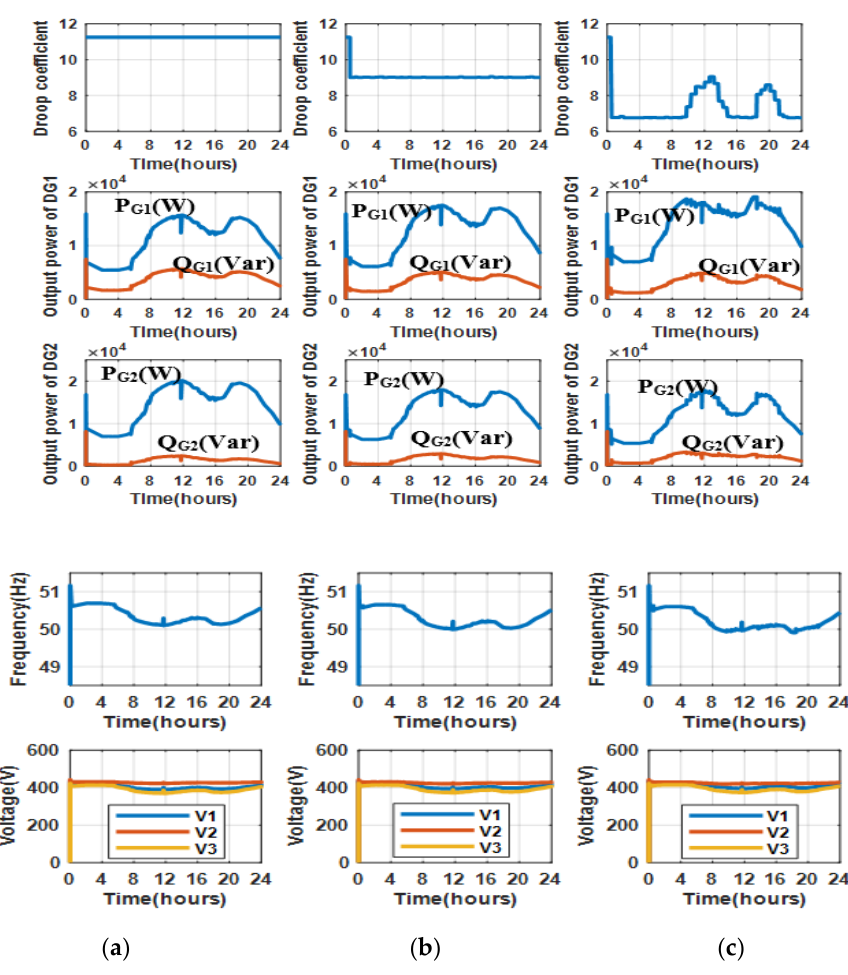
Figure 17. Experimental results for the MG in 24 h: ( a ) Scenario 1; ( b ) Scenario 2; ( c ) Scenario 3. System frequencies and voltages in the three scenarios fluctuate within the limitation. The responses of frequency and voltages are smooth, as confirmed in Figure 17, from 49.9 Hz to 50.7 Hz for frequency, from 394 V to 435 V for voltage, respectively.